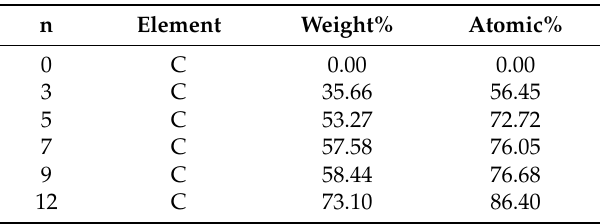
Figure 1. Ultraviolet-visible near-infrared (UV–vis-NIR) spectroscopy of the (CNTs/PAH) n -deposited ITO electrode (n = 3, 5, 7, 9, 12). Table 1. The content of C element on the (CNTs/PAH) n -deposited ITO electrode analyzed by energy dispersive spectroscopy (n = 0, 3, 5, 7, 9, 12).